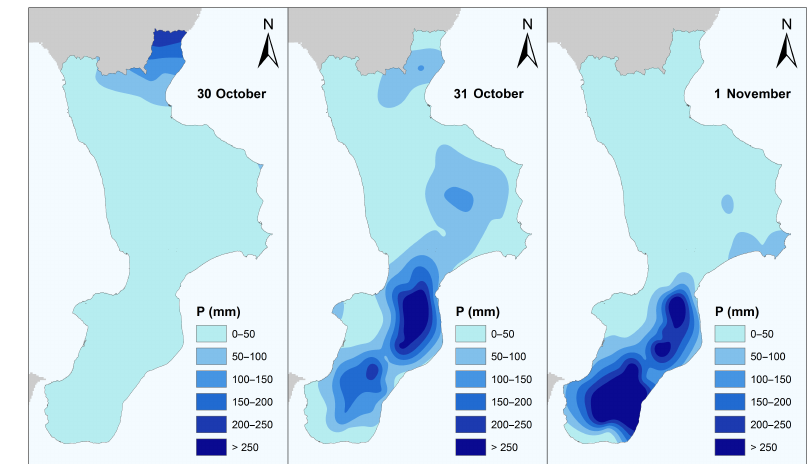
Figure 5. Spatial and temporal distribution of the daily rainfall for the 2015